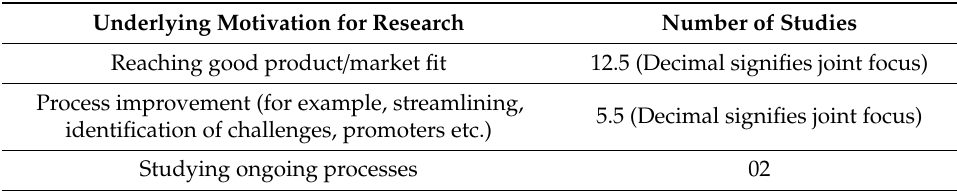
Table 8. Underlying motivation for research (on basis of challenges supporting research or challenges